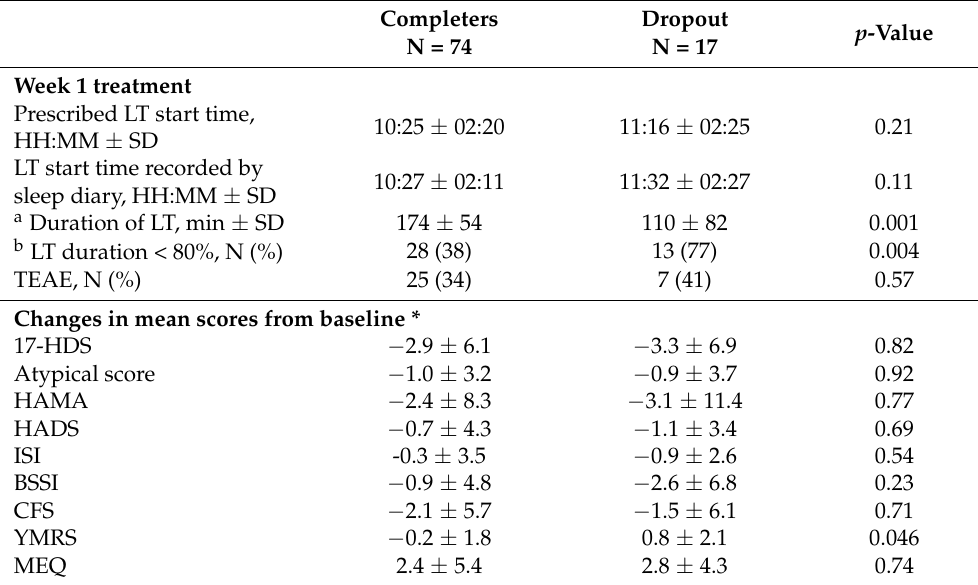
Table 3. Treatment adherence and early changes in clinical outcomes from baseline to week 1.